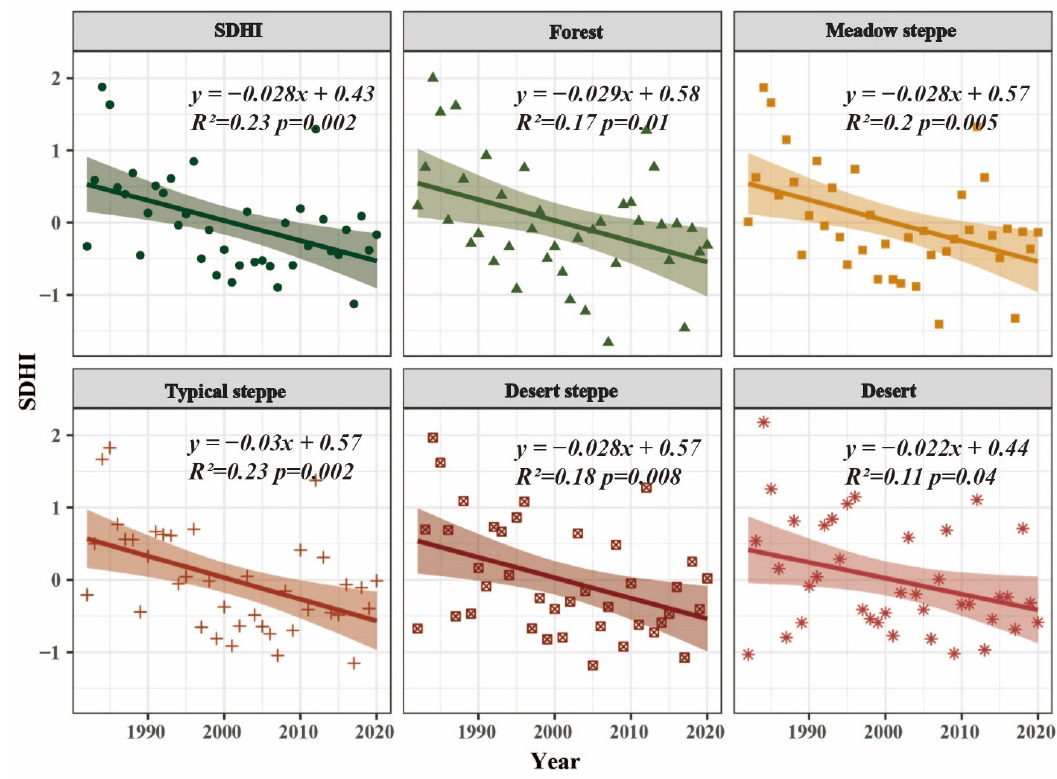
Figure 2. Variation trends of SDHI mean value for overall and each grassland type in Inner Mongolia from 1982 to 2020.